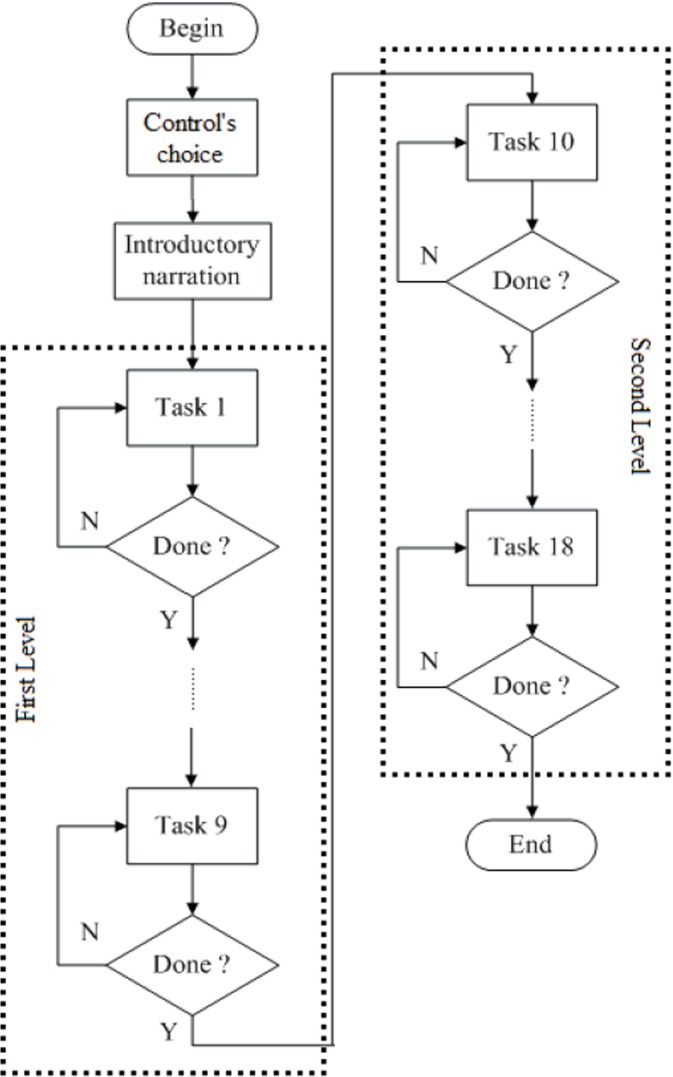
The game’s logical diagram [6].